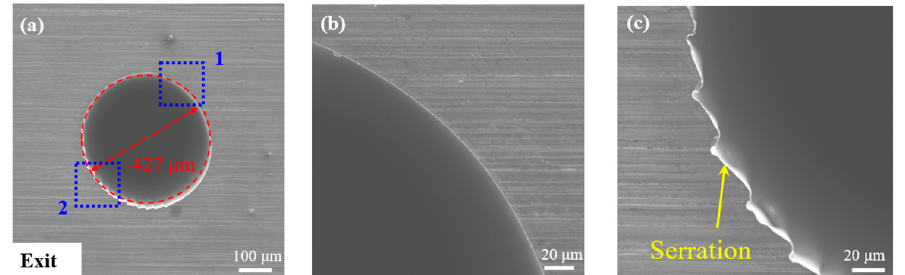
Figure 11. Enlarged view of the 2-2-3-4-5-1 exit hole morphology micro area ( a ) exit hole; ( b ) area 1; ( c ) area 2.